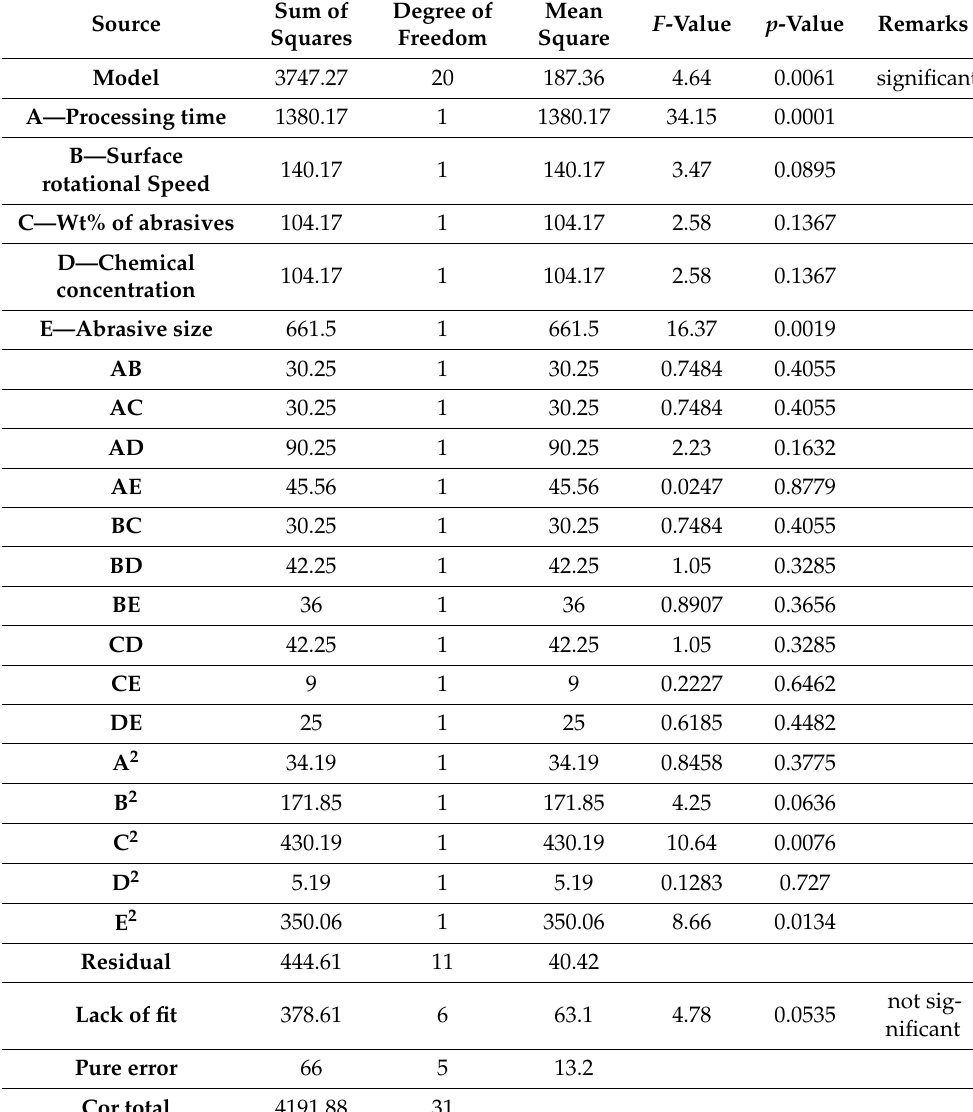
Table 4. ANOVA for PIESH.